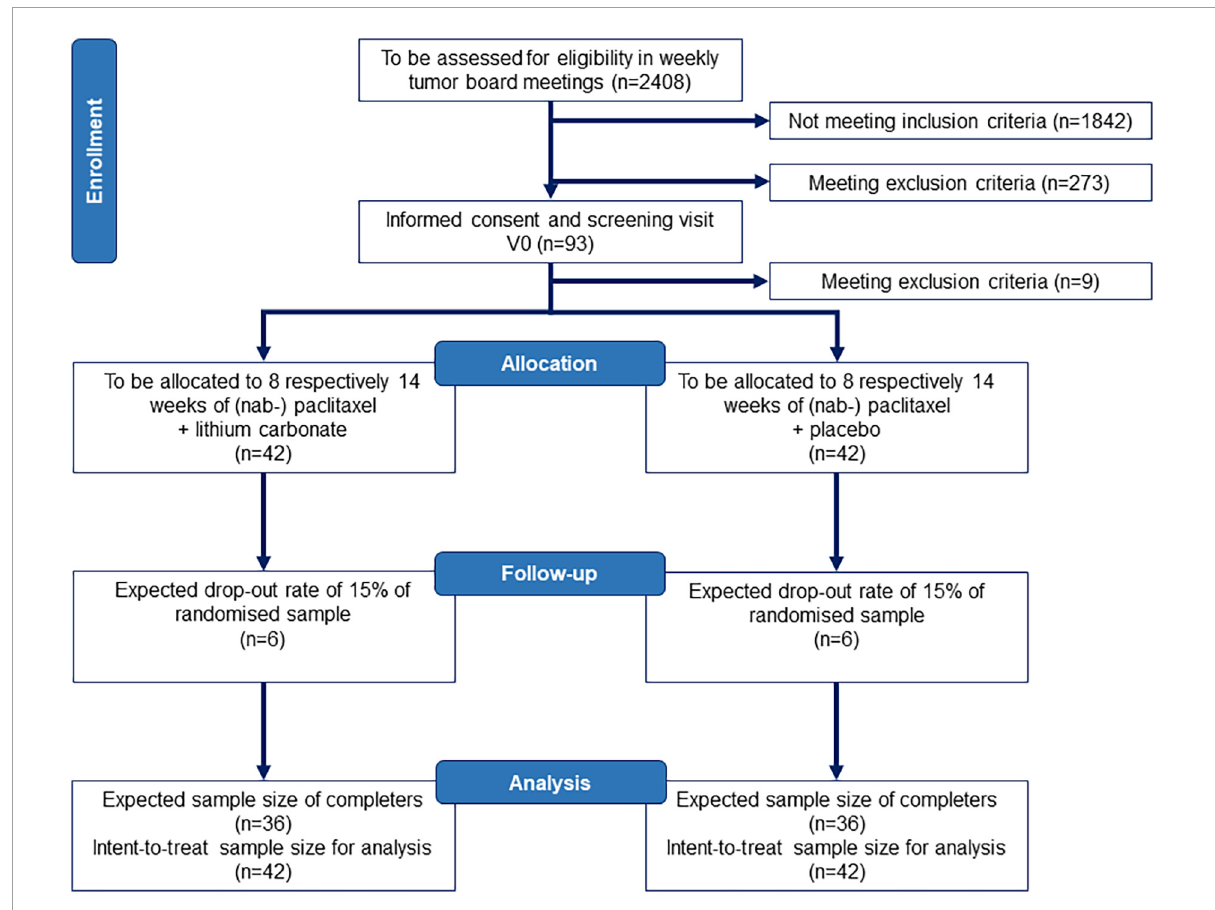
FIGURE1 Study flow chart according to CONSORT. We assume that we need to screen n = 2408 patients with breast cancer according to punch biopsy or surgical resection pathology for eligibility at five to eight recruiting centers to enroll n = 93 and randomize n = 84 patients aged 18–70 years. The sample size and drop-out rate (15%) is conservatively based on other studies in CIPN (34, 35) and data from our own pilot study of CIPN development in breast cancer patients (36) as well as treatment effects for lithium carbonate in the prevention of CIPN in rodents (16, 21). CONSORT, Consolidated Standards of Reporting Trials.